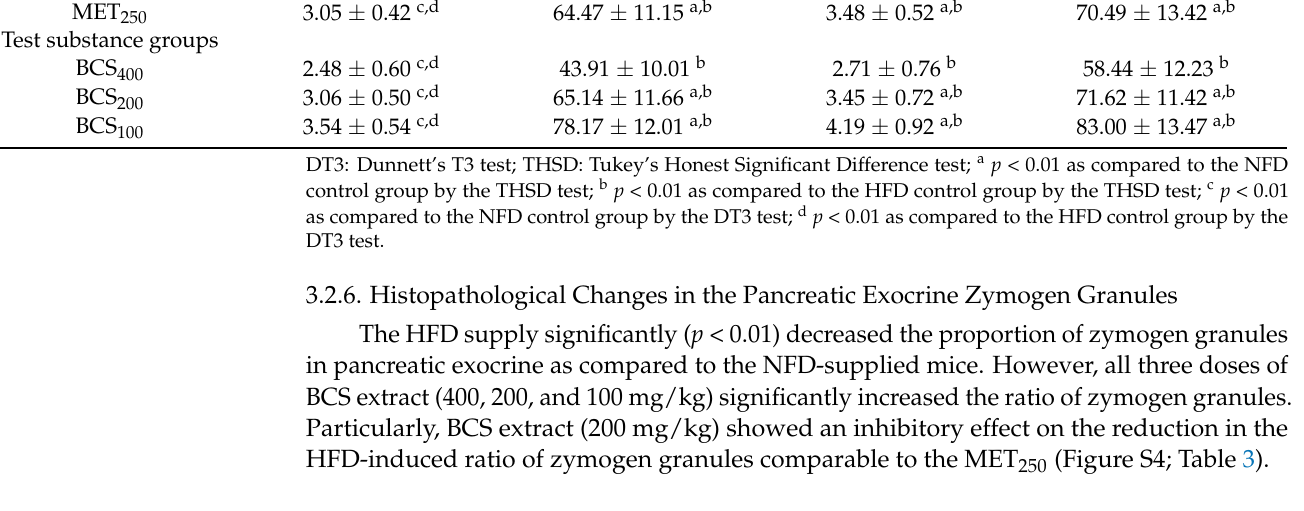
Table 3. Histopathology–histomorphometry of the pancreas in HFD- and NFD-supplied